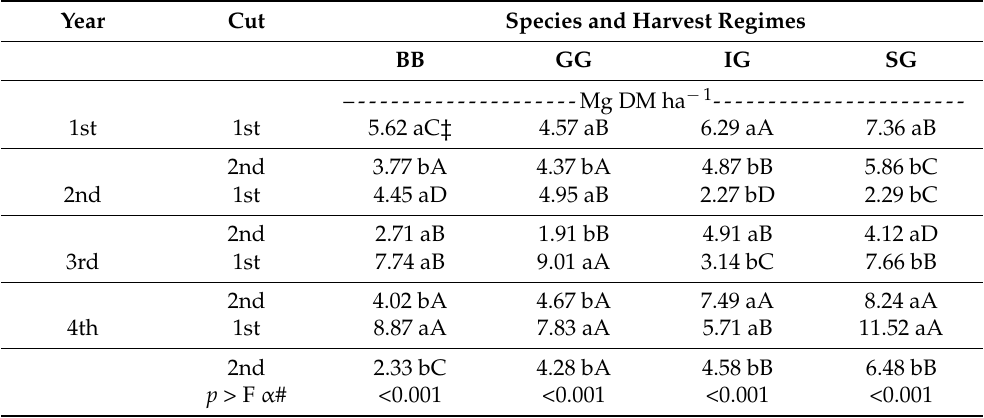
Table 6. Sequential forage biomass production of two-cut systems in newly established NWSG† stands recorded for four consecutive years starting June